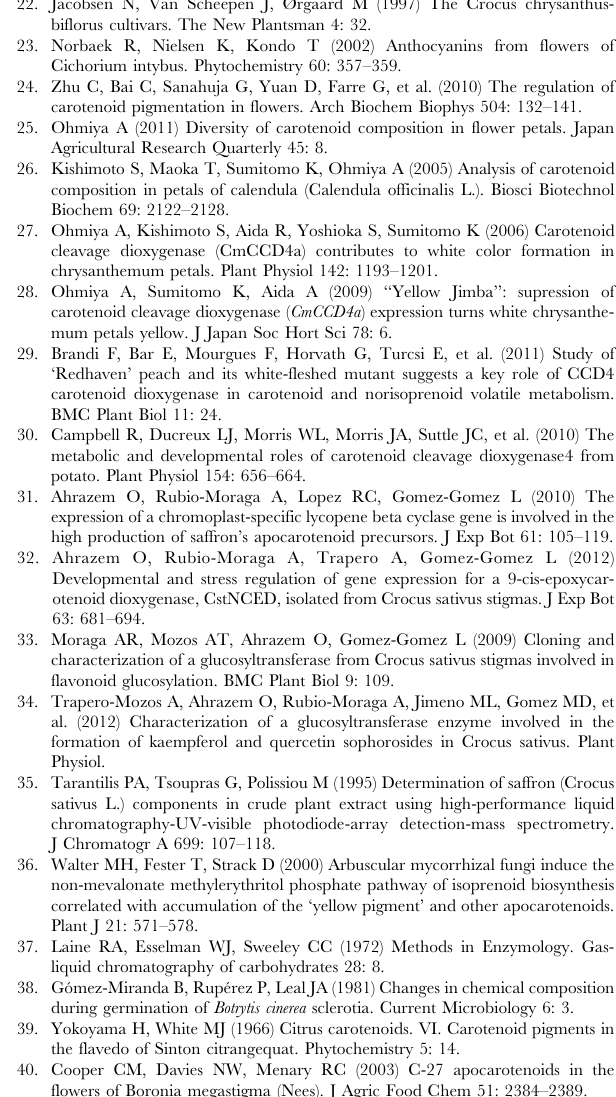
Table S1 Flowering time, tepal color and distribution of Crocus species from section Nudiscapus. The most recent classification is from Mathew (Mathew, 1982). He divided section Nudiscapus in nine series based on the division of the style, corm tunic features and flowering time. Crocus species with yellow tepals are highlight in